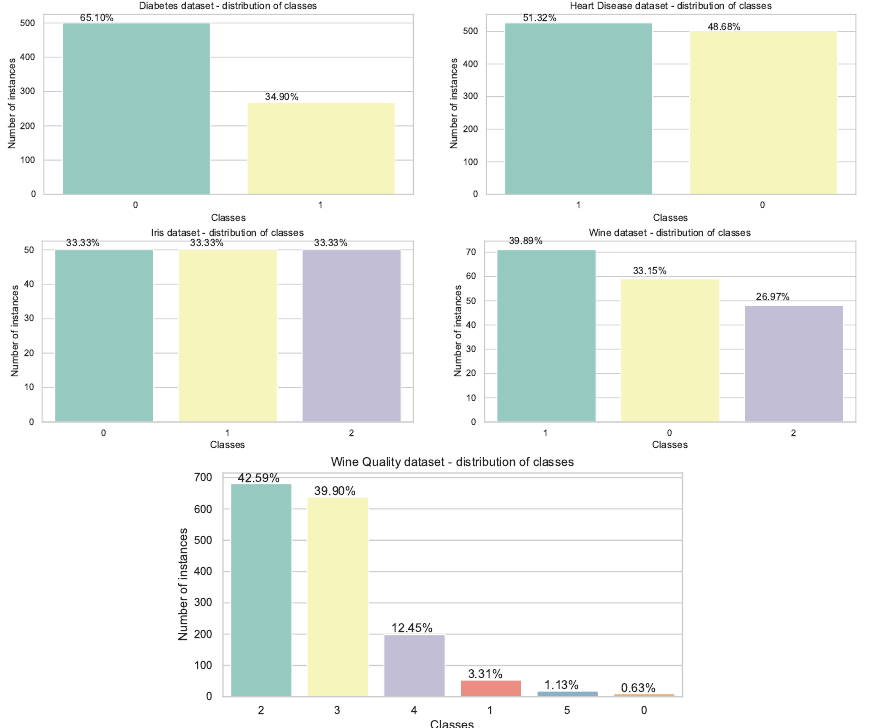
Figure 2. Distribution of classes in Diabetes, Disease, Iris, Wine, and Wine Quality datasets be- fore